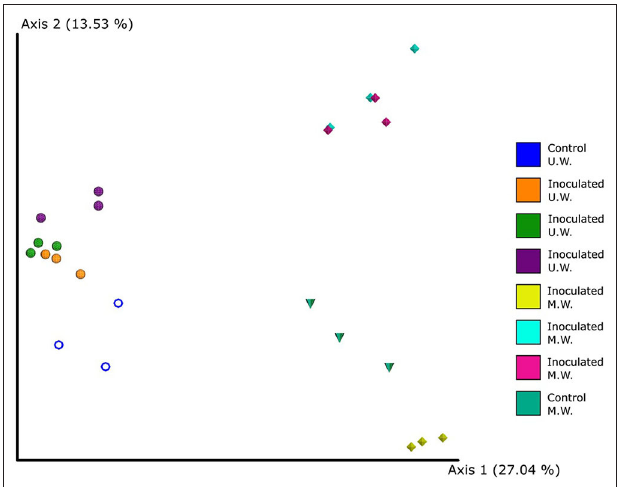
FIGURE 8 | The beta diversity of the prokaryotic communities of the columns at day 40 where sequences with ≥ 97% similarity to Aminobacter sp. MSH1 had been removed from the dataset. The PCoA shows Bray-Curtis dissimilarity matrix calculated through Emperor. Columns received during operation a feed of either untreated water with 0.3 µ g l − 1 BAM (U.W.) or membrane retentate water with 3.0 µ g l − 1 BAM (M.W.). Individual colors represent samples from the same column. The two control columns run without initial inoculation are represented by the blue circles and teal cones,